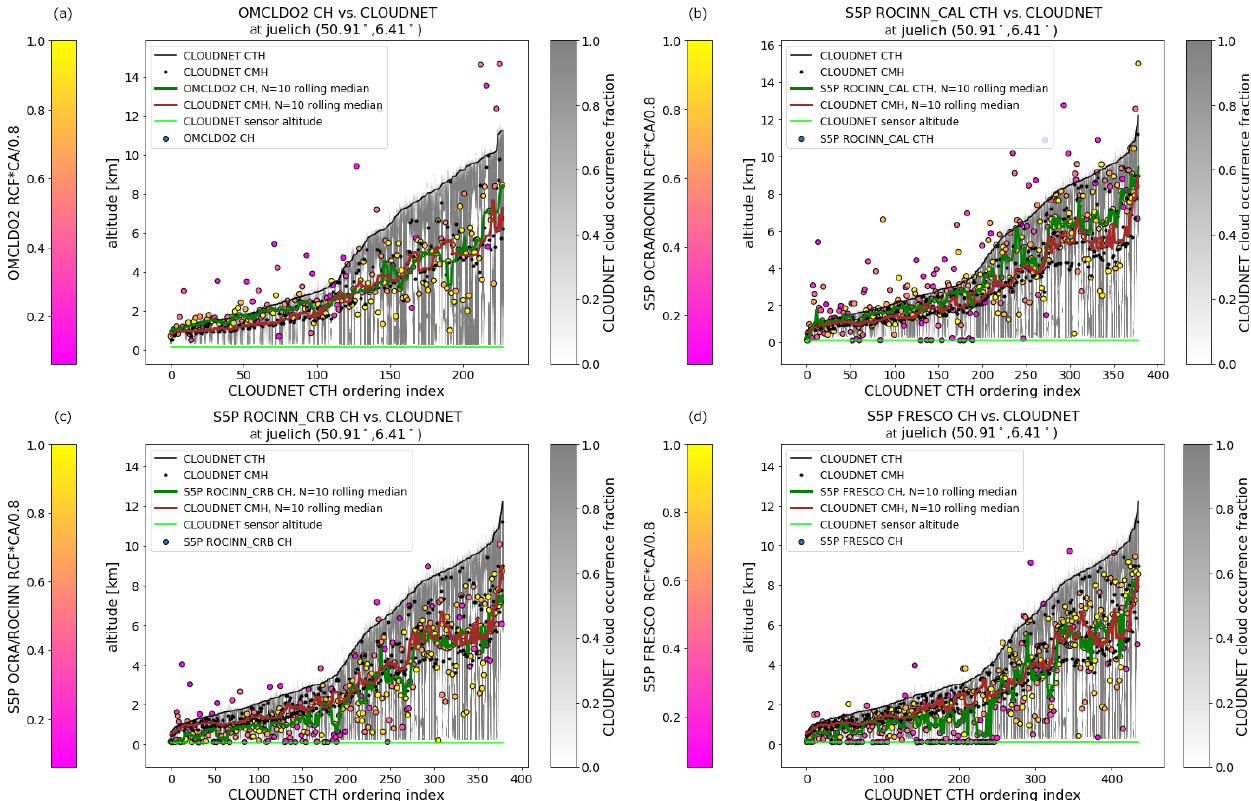
Figure 8. Comparisons of OMCLDO2 CH (a) , S5P OCRA/ROCINN_CAL CTH (b) , S5P OCRA/ROCINN_CRB CH (c) , and S5P FRESCO CH (d) with Cloudnet at the site Juelich. Along the x axis, the cases are ordered according to the Cloudnet CTH. Black line indicates the Cloudnet CMH. Satellite data points are coloured based on the sRCF (left colour bar). Ten-point window rolling medians based on the satellite data (green line) and on the Cloudnet CMH data (brown line) are added as well. The grey background is the vertically resolved cloud occurrence fraction derived from the Cloudnet data for the period ± 600s of the satellite overpass (right colour bar).